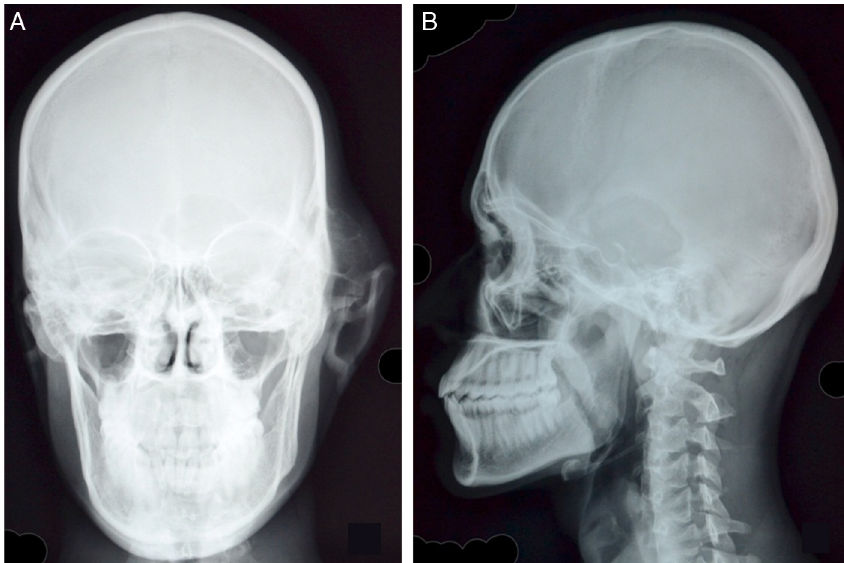
Figure 1 (A) Skull PA view reveals swelling of osseus origin overlying left temporal bone with thinned out cortex and interlacing septae. There is associated breach in the cortex of left greater wing of sphenoid and non-visualization of left petrous bone. Soft tissue swelling and lateral displacement of left pinna is seen. (B) Lytic, geographic lesion in left temporal bone with, narrow zone of transition and irregular, sclerotic margins is well appreciated on the lateral view.